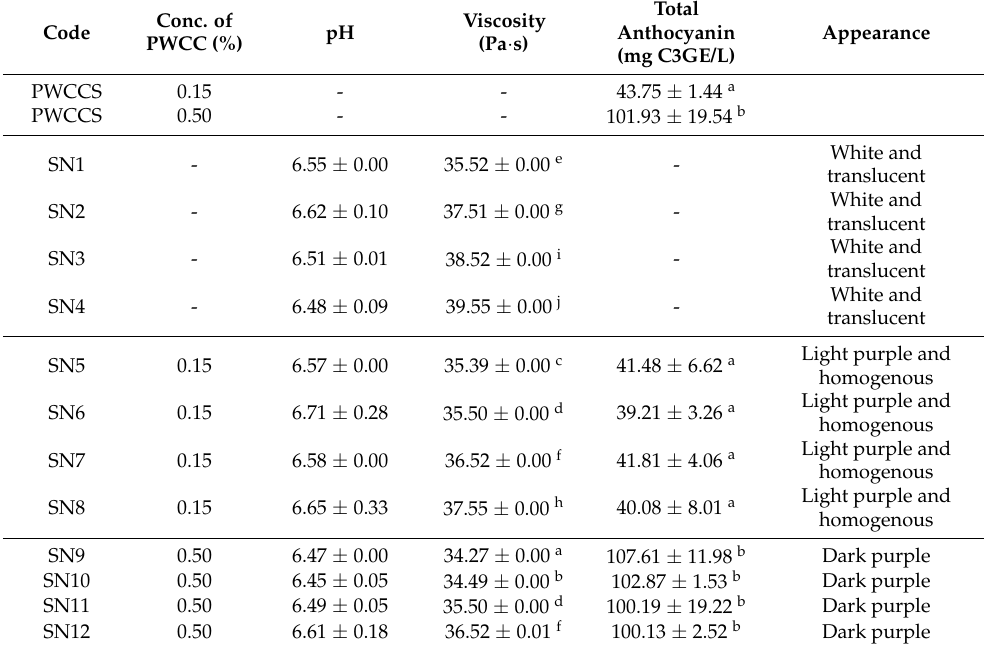
Table 2. Physical characteristics and total anthocyanin content of sericin hydrogels and extracts.